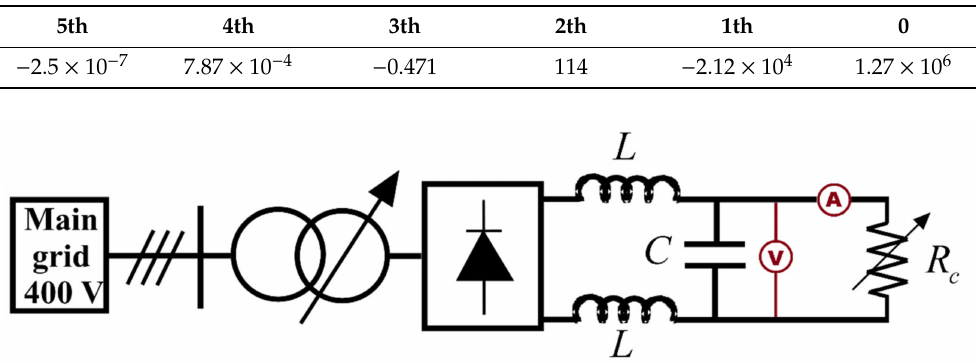
Table A1. Polynomial coe ffi cients.